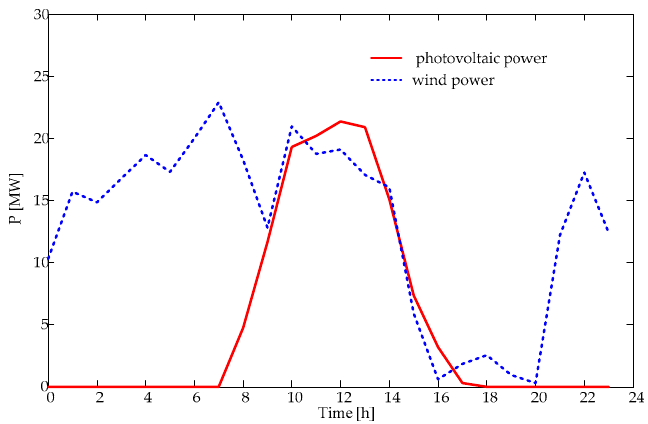
Figure 3. Prediction of wind power and photovoltaic power.